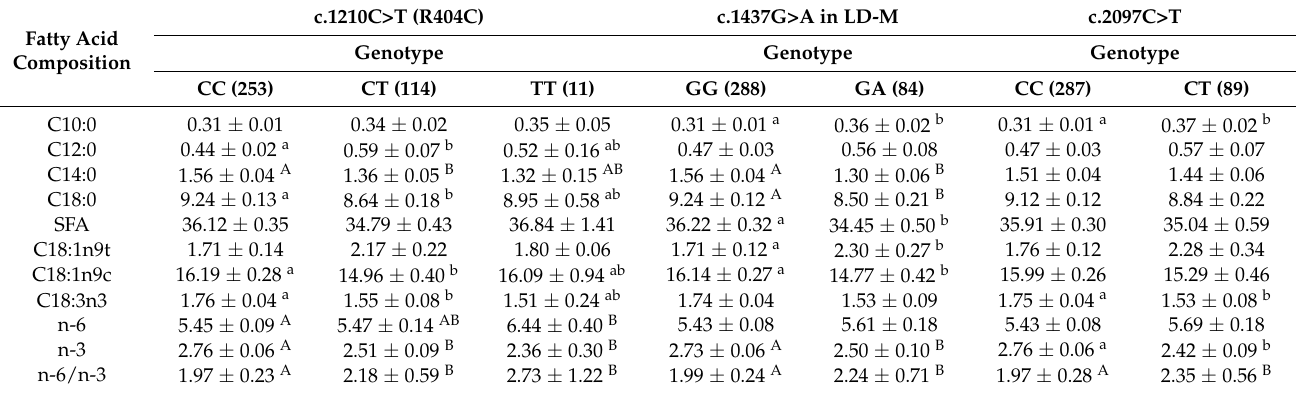
Table 3. Associations of CAST variants with fatty acid composition in the longissimus thoracis muscle of Sonid sheep.